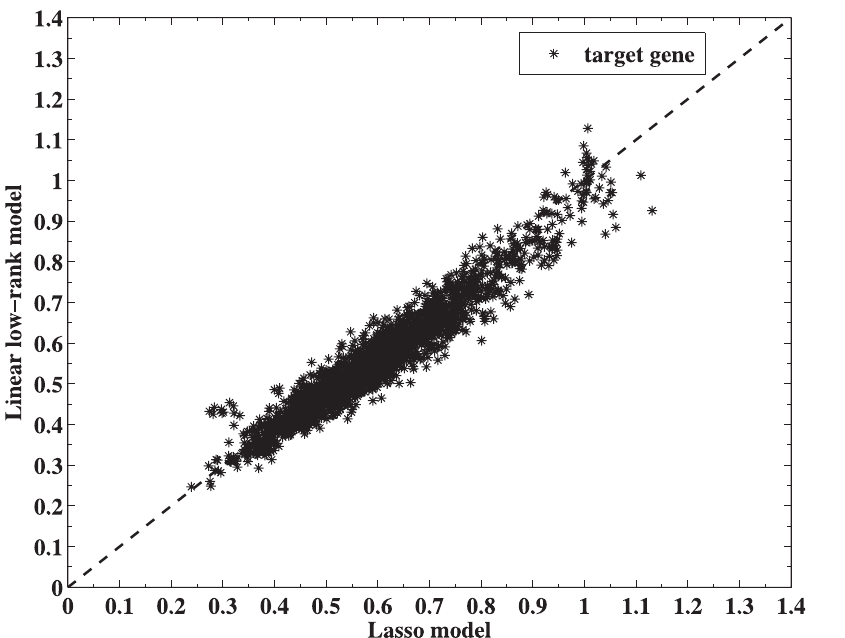
Figure 1. Comparison of the testing performance of the linear low-rank regularization model vs. Lasso on the yeast gene expression dataset. Each * indicates one target gene. X-axis represents the test RMSE of the Lasso model, whereas Y-axis represents the test RMSE of the linear low-rank model. The figure shows that the low-rank model yields lower testing error than Lasso for most target genes.